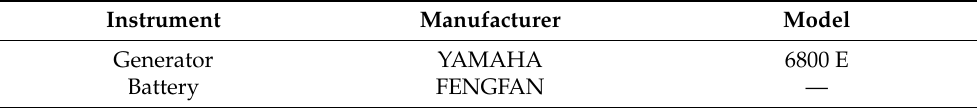
Table 2. Models and specifications of the other instruments.